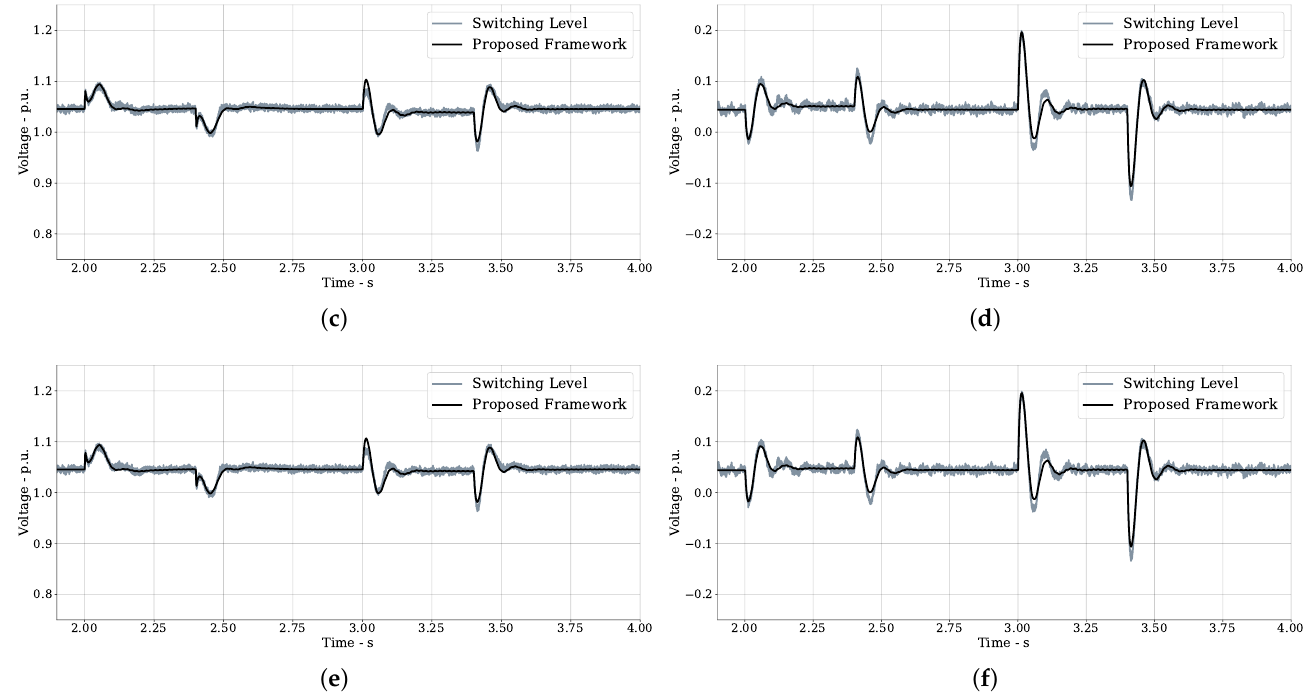
Figure 11. Bus Voltages: comparison between the proposed model and the switching-level PSCAD model. ( a ) Bus 1: d axis; ( b ) Bus 1: q axis; ( c ) Bus 2: d axis; ( d ) Bus 2: q axis; ( e ) Bus 3: d axis; ( f ) Bus 3: q